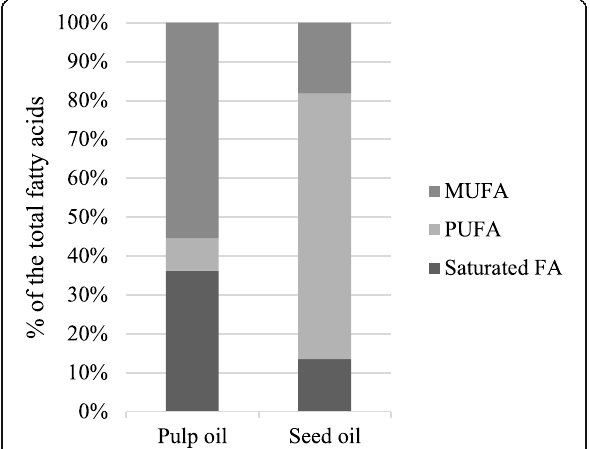
Fig. 1 Graphical representation of total fatty acids presents in sea buckthorn oils, adapted from Dulf (2012). MUFA; mono-unsaturated fatty acids, Saturated FA; saturated fatty acids, and PUFA; poly- unsaturated fatty